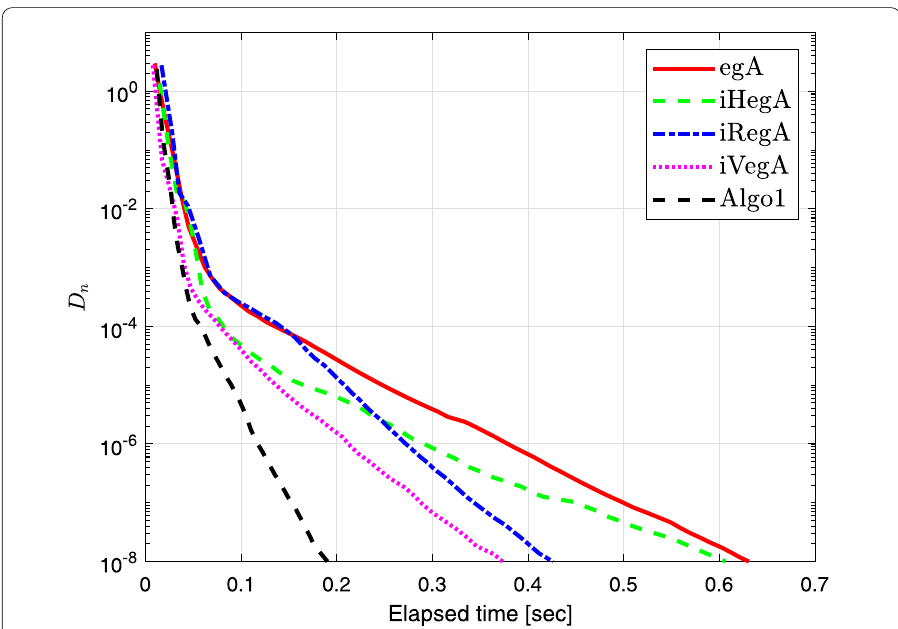
Figure 1 Example 5.1 when n = 5: the number of iterations is 63, 56, 46, 38, 44, respectively